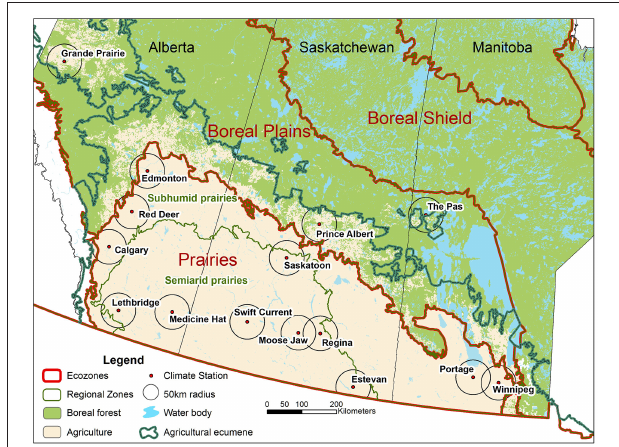
FIGURE 1 | Climate station locations, Canadian ecozones, regional zones, agricultural regions, and boreal forest.